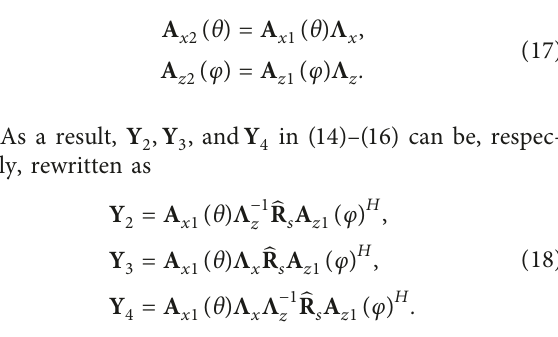
Figure 1: L-shaped ULA